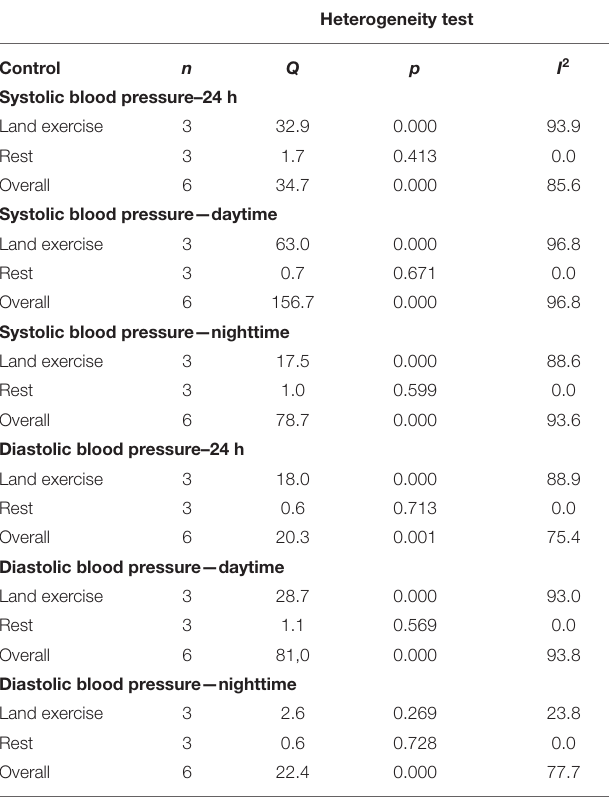
TABLE 5 | Heterogeneity of